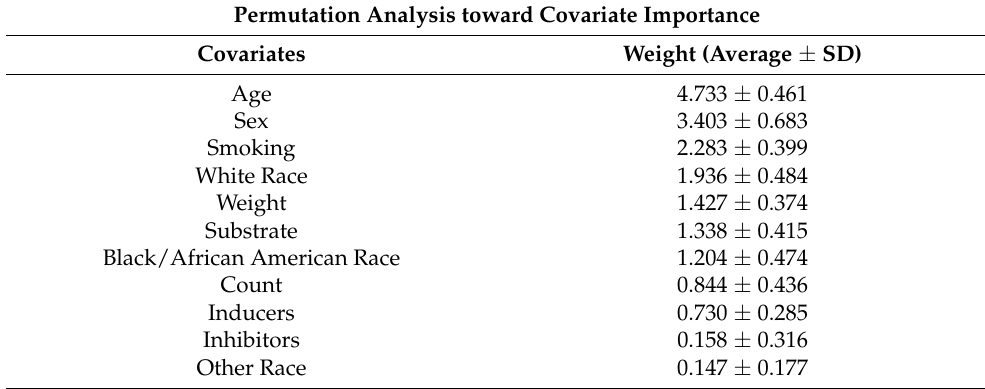
Table 5. Mean PIMP scores from the permutation analysis of the LSTM-ANN